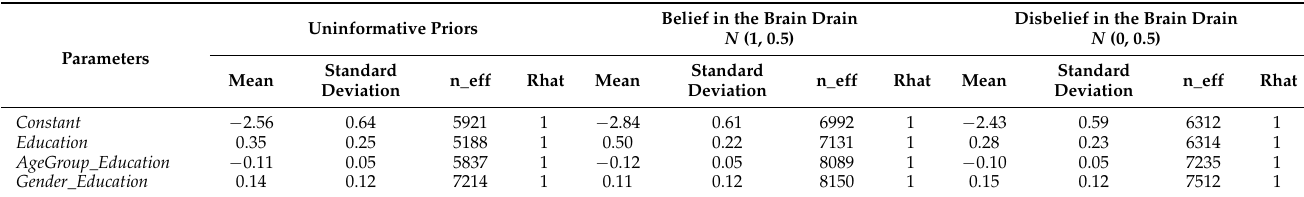
Figure 3 demonstrates all posterior parameters’ trace plots. The posterior value of each parameter is represented on the y -axis, while the x -axis indicates the iteration order. Four colored lines in the middle are the Markov chains. If the Markov chains fluctuate around a central equilibrium, they can be deemed good-mixing and stationary. These two characteristics are signals that the Markovian property is held. The Gelman plots of Model 1 (cid:48) s parameters are presented in Figure 4. The shrink factor (or Gelman factor), used to assess the relativeness of the variance between Markov chains and the variance within chains, is presented on the y -axis. There is no divergence among Markov chains, as the shrink factors of all parameters drop quickly to 1 during good